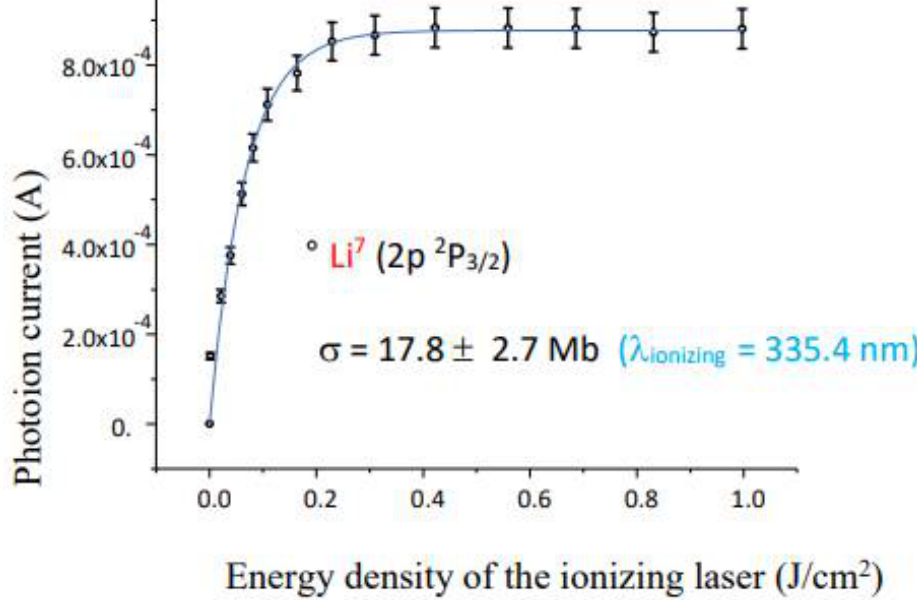
Figure 3. Photoion current signals of Li 7 from the 2p 2 P 3/2 excited states versus the energy density of the ionizer laser at 335.4 nm ionizing laser wavelength.